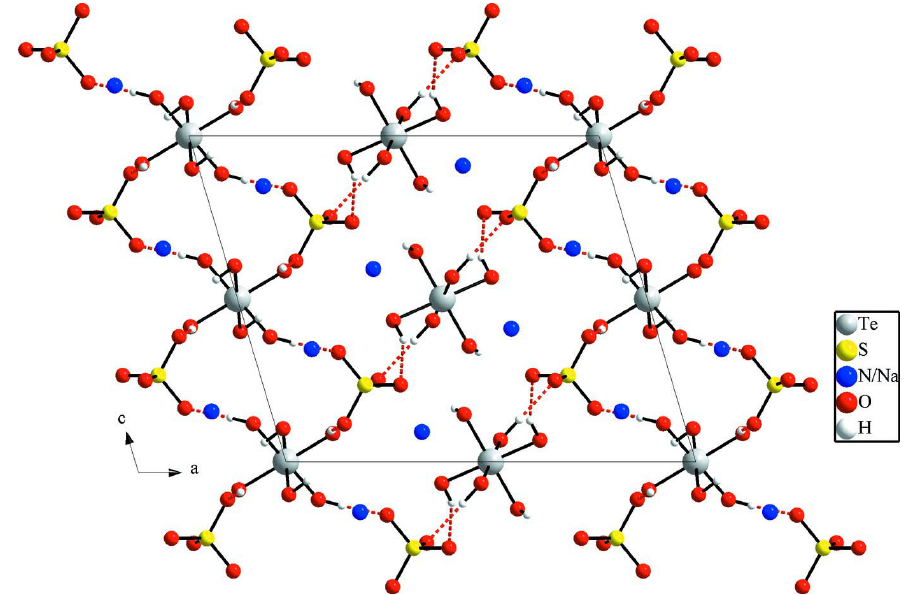
(NH ) SO .Te(OH) showing hydrogen bonds with dashed lines. 0.39 4 1.61 4 6